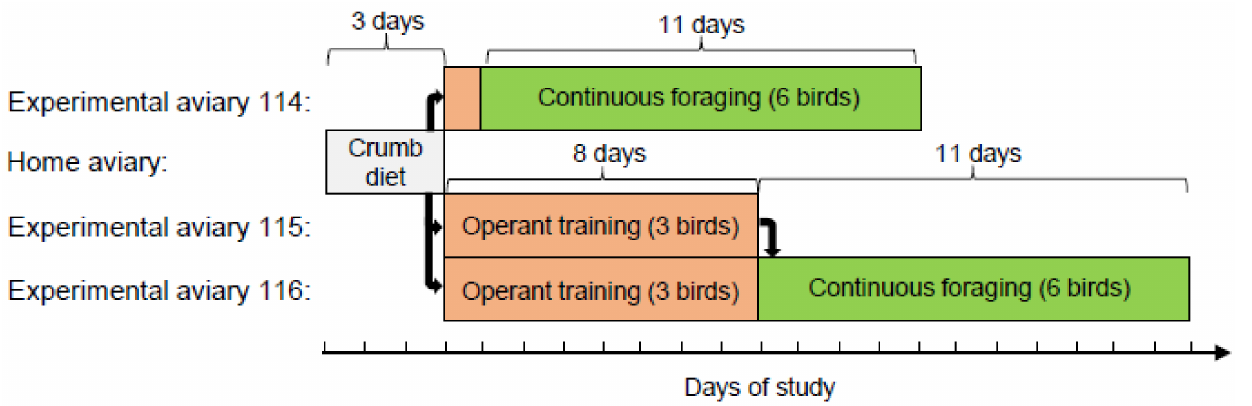
Figure 2. Scheme showing the study design and timeline for the 12 birds used in this study. During operant training, there was one SFS station per aviary and during continuous foraging, there were two stations per aviary. Thus, the ratio of birds per SFS station was maintained at 3:1 throughout. The entire study lasted 22